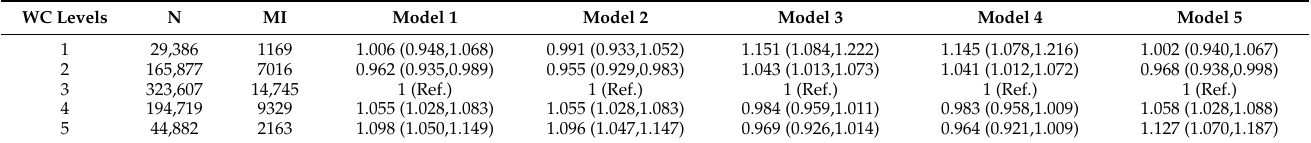
Table 4. Cox’s proportional hazard model for the incidence of new-onset MI according to WC.